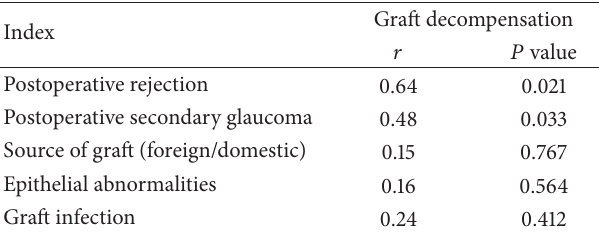
Figure 3: Kaplan-Meyer analysis of graft survival in the infectious andnoninfectioussubgroupswithintheforeignanddomesticdonor groups. Table 6: Spearman analysis for the factors affecting postoperative graft